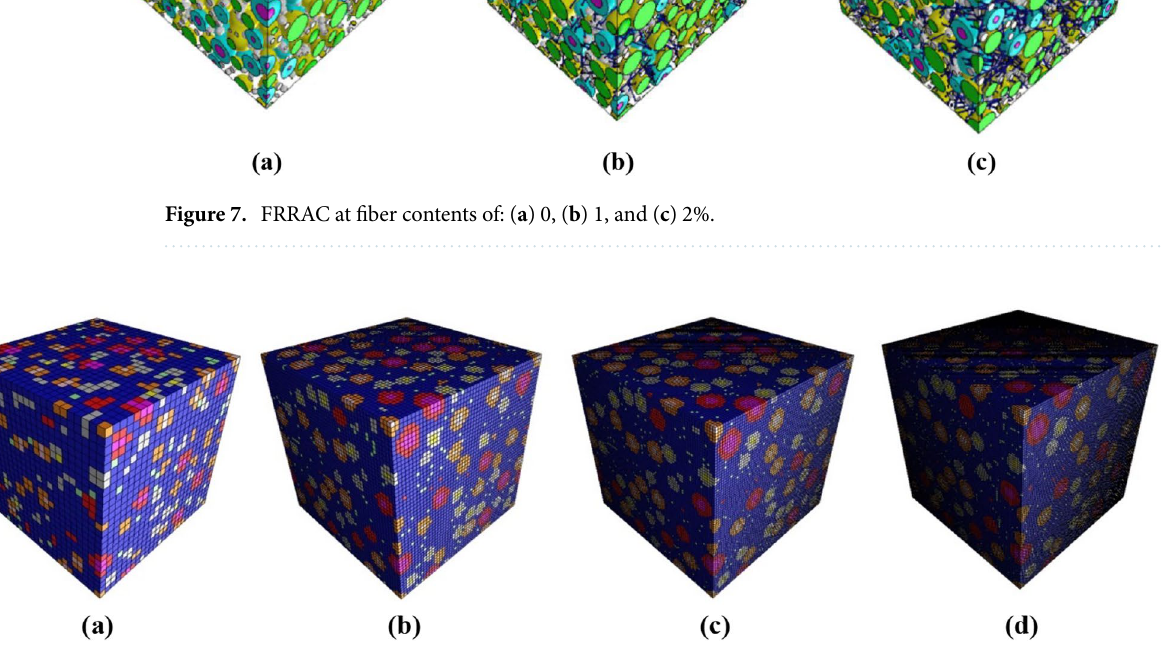
Figure 8. FRRAC RVE models at macroscale at different sizes of: ( a ) 4, ( b ) 2, ( c ) 1.33 and ( d ) 1